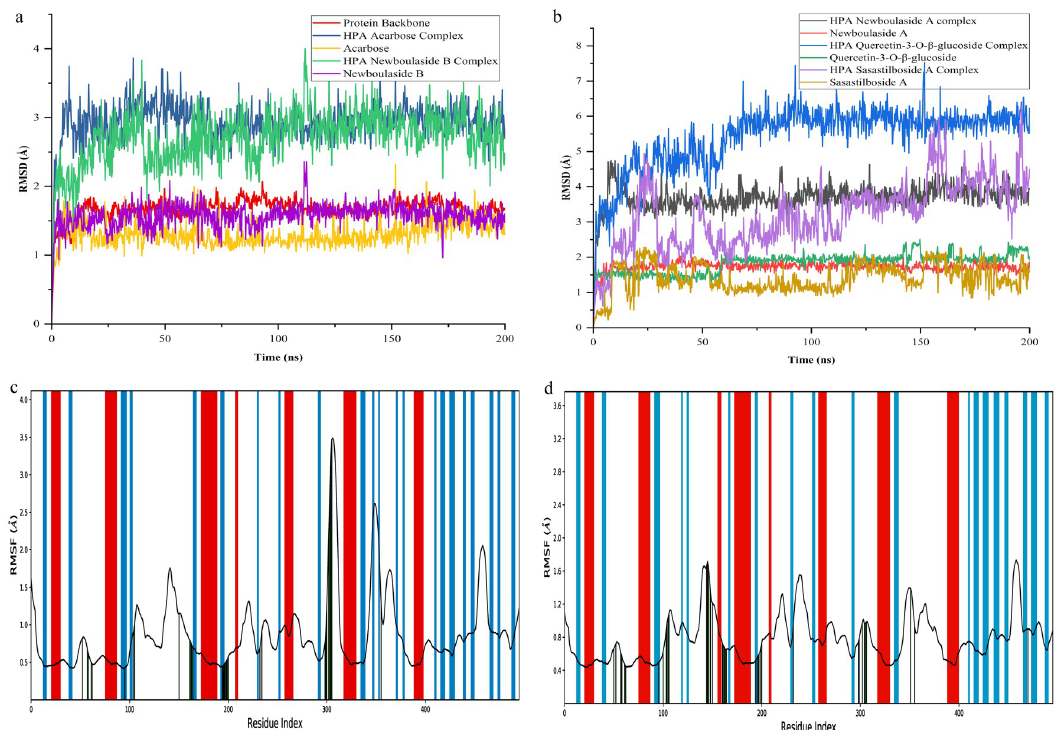
Fig 3. RMSD and RMSF analysis of MD simulation trajectory: The RMSD plot obtained for HPA (a) acarbose and newboulaside B complex, and (b) newboulaside A, quercetin-3-O- β -glucoside, and sasastilboside A complex. The RMSF plot was obtained for HPA (c) acarbose complex, and (d) newboulaside B complex. The strand, helix, and loop region of HPA are represented as blue, red, and white, respectively.